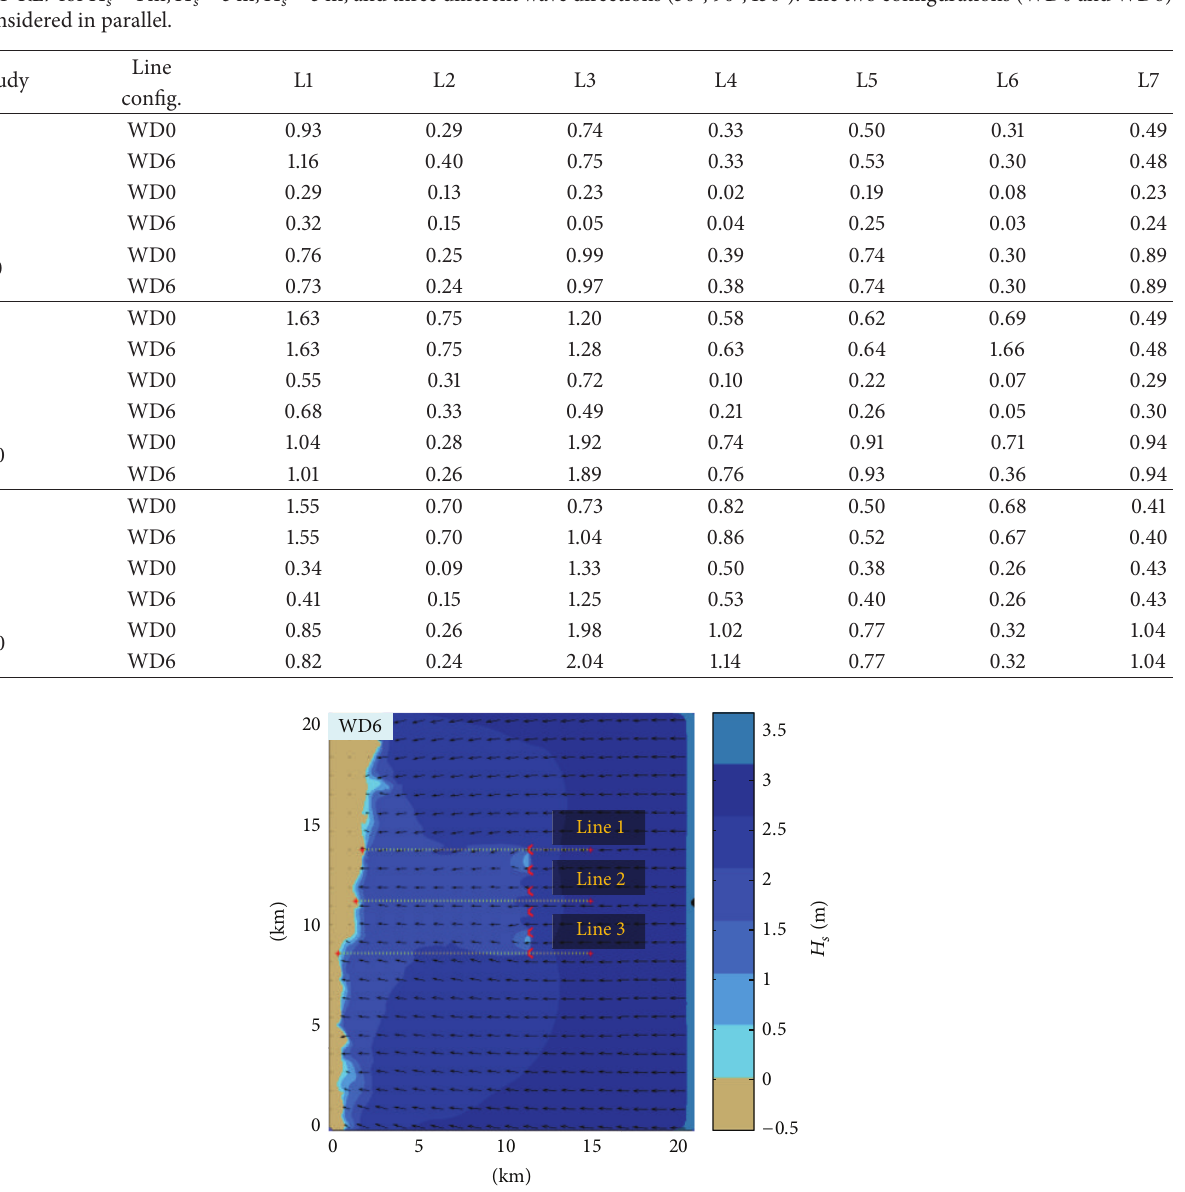
Figure 11: Evaluation of the impact of the energy farms on the maximum velocities of the nearshore currents along the reference lines considered. (a) CS1, (b)